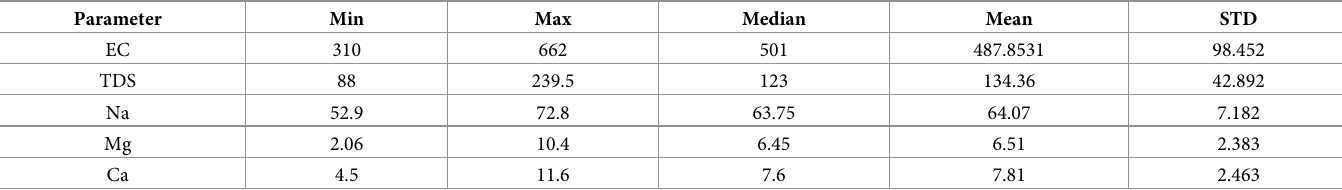
Table 8. Water quality characteristics from 0.75 m column depth